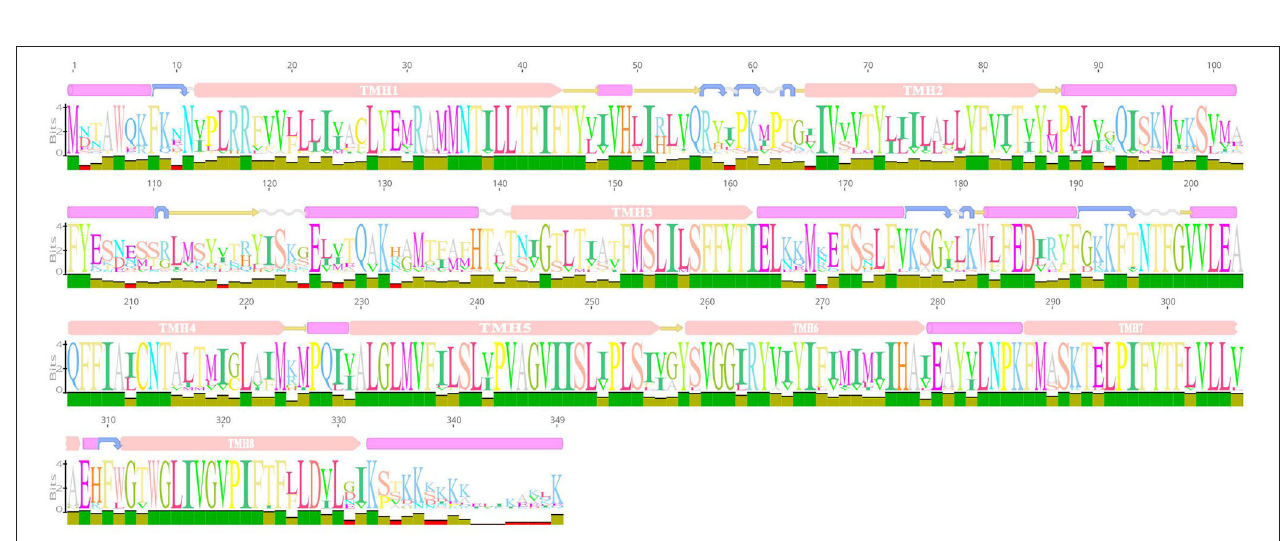
FIGURE 1 | Phylogenetic analysis of AI-2E family transporter protein of Lactobacillus acidophilus CICC 6074. Phylogenetic relationship between AI-2E proteins of Lactobacillus (A) , 530 AI-2E protein sequences of Lactobacillus were downloaded from IPG of NCBI, the AI-2E protein of L . acidophilus is marked with a red star. Phylogenetic relationship between AI-2E protein of L. acidophilus CICC 6074 and AI-2E family members (B) , phylogenetic analysis using the AI-2E protein of L . acidophilus with its homologous proteins, and the AI-2E protein of L. acidophilus is marked with a red star.